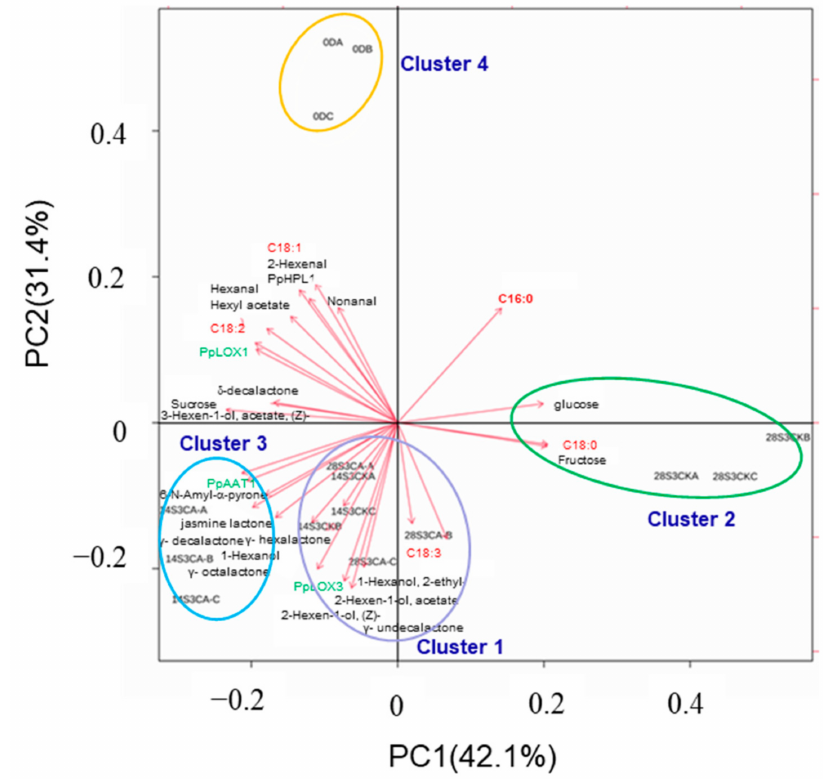
Figure 9. Biplot for the first two principal components of PCA for production of volatiles, fatty acids, soluble sugars and genes expression derived from the LOX pathway in peach fruit during shelf-life after cold storage. 28S3CK-A: the first number represents days after postharvest storage, S means shelf-life, 3 means the days during shelf-life, and the last letters means the replicate